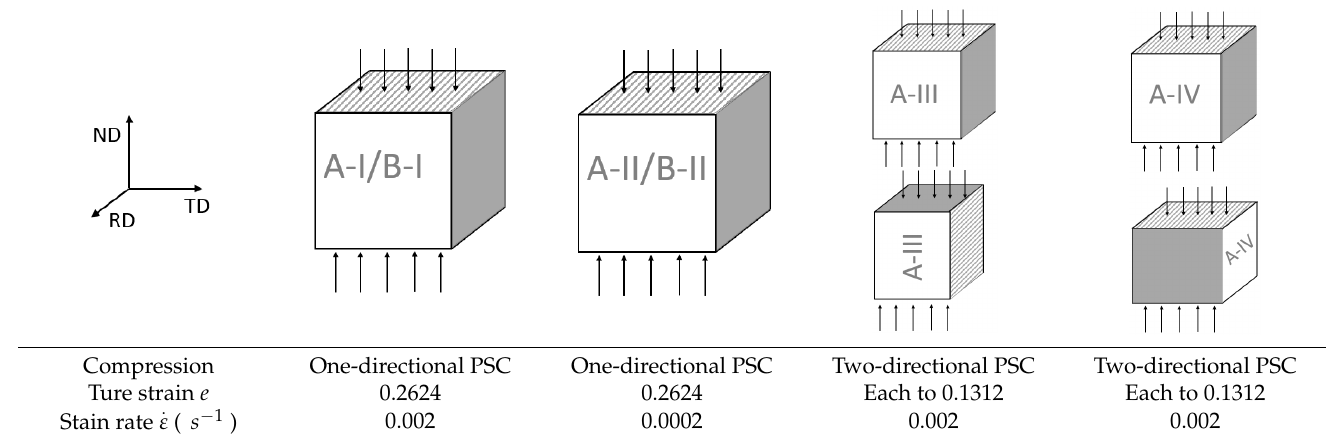
Table 1. Sample geometry and the testing parameters.